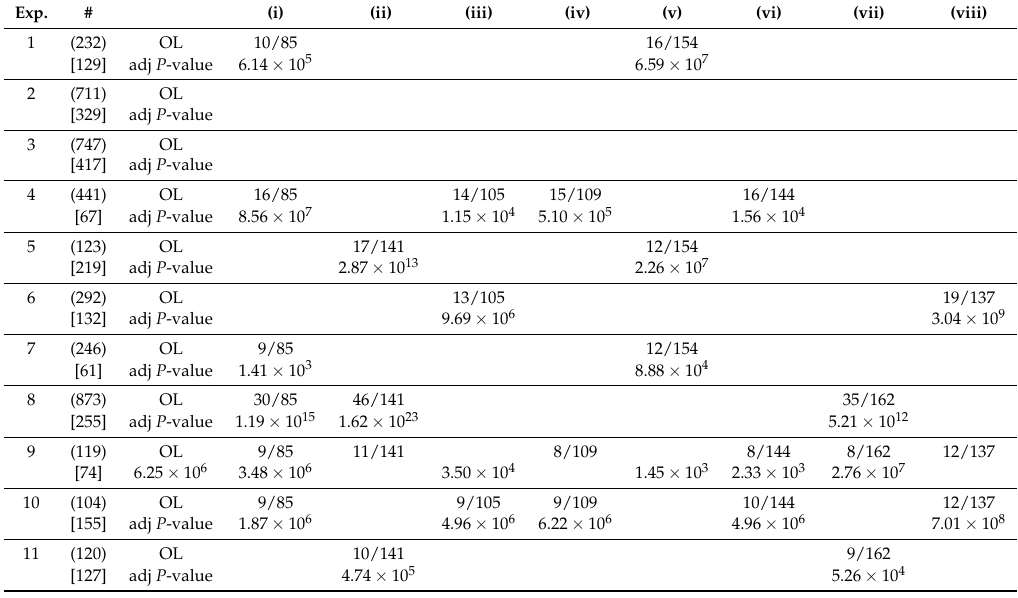
Table 5. In each of 11 experiments, 20 top-ranked significant treatments with compounds whose downregulated genes significantly coincide with some genes selected for each experiment were identified. Thus, treatments with the following compounds are most frequently ranked within top 20.